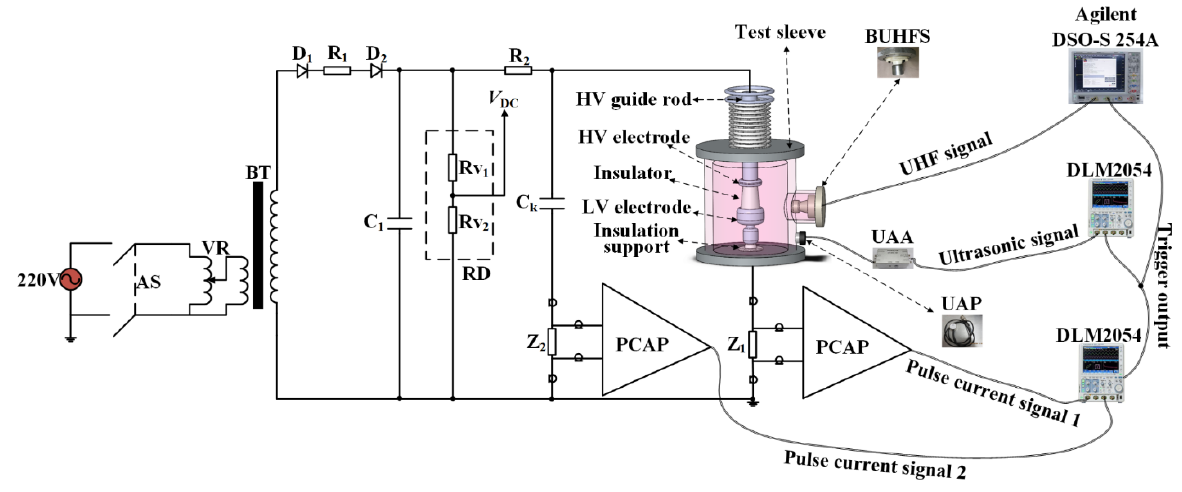
Figure 1. The schematic diagram of the experimental platform.